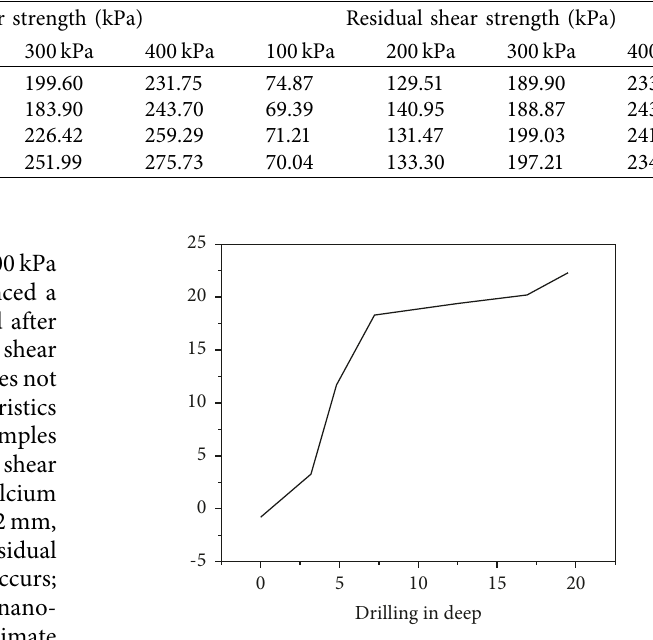
Table 4: Peak shear strength and residual strength values of each group of samples.